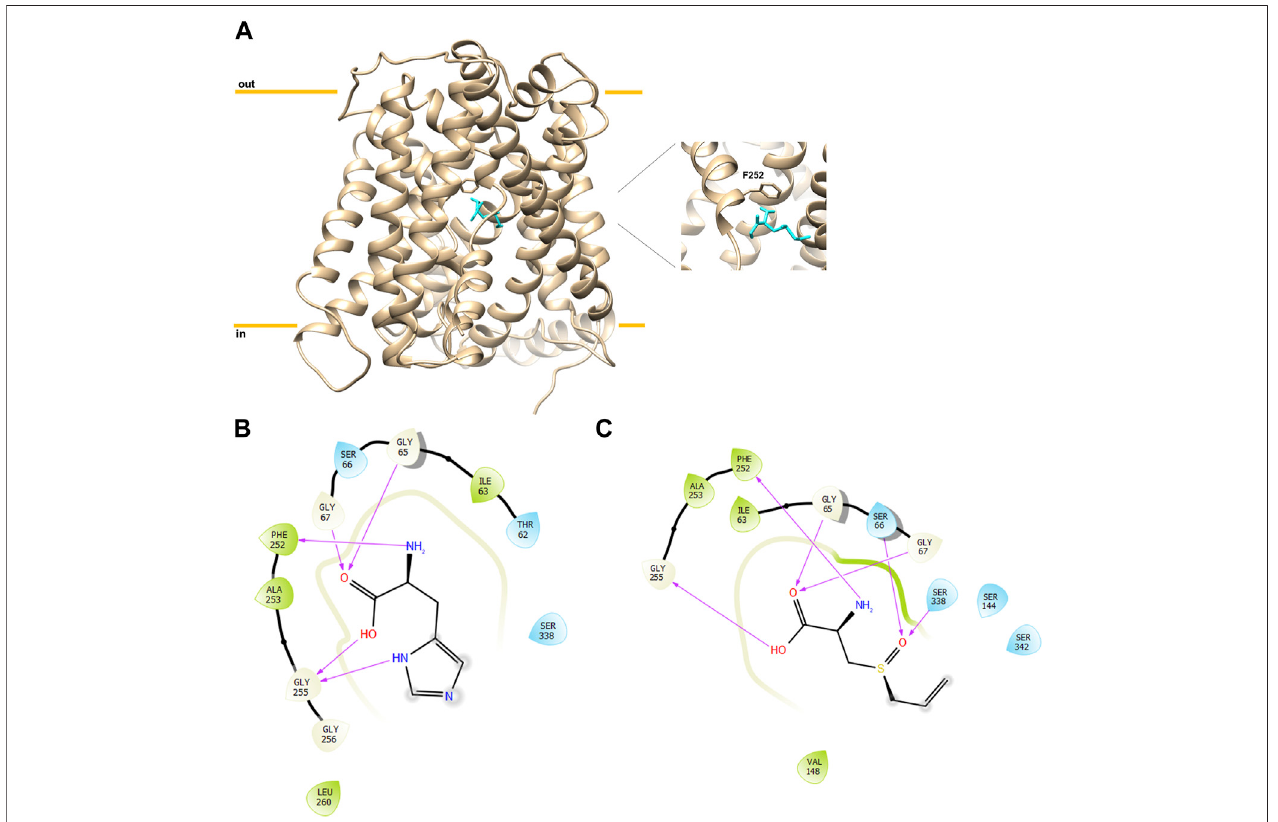
FIGURE 1 | Docking analysis of hLAT1. The cryo-EM structure of hLAT1 in inward conformation (PDB ID: 6IRT, chain B) was represented as ribbon (sand) using Chimera v.1.7 software (https://www.cgl.ucsf.edu/chimera). In (A) , docking analysis was performed using InducedFit XP docking 5 as described in Materials and Methods.Moleculardockingofalliin(skyblue)inthesubstratebindingsiteofhLAT1withthegateresidueF252representedassticks(sand).Inthezoom,theposeofalliin with the docking score of − 6.99 kcal/mol and a glide e-model of − 72.237. The membrane and intracellular/extracellular environment are indicated. In (B) , 2D visualizationofhLAT1interactionwithhistidine.Thearrowsindicatetheresiduesinvolvedinthebinding.In (C) ,2DvisualizationofhLAT1interactionwithalliin.Thearrows indicated the residues involved in the